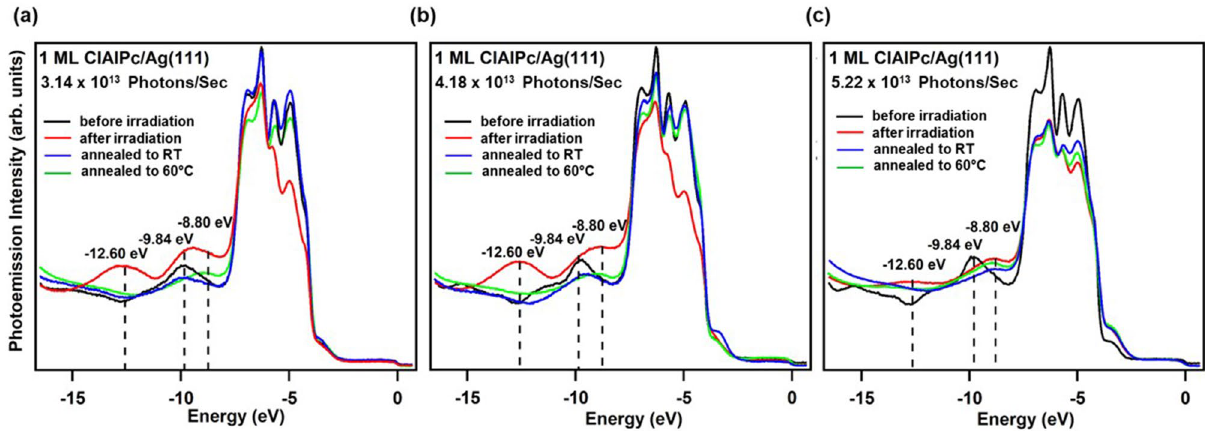
Figure 5. Photoemission spectra of 1-ML ClAlPc on Ag(111) crystal at the stages of before-irradiation, after- irradiation, post-annealed-to-RT, and post-annealed-to-60 °C at photon flux of ( a ) 3.14 × 10 13 photons/sec, ( b ) 4.18 × 10 13 photons/sec, and ( c ) 5.22 × 10 13 photons/sec. The black dashed lines indicate the energy positions of the Cl-down, Cl-up and anomalous molecular-energy-state